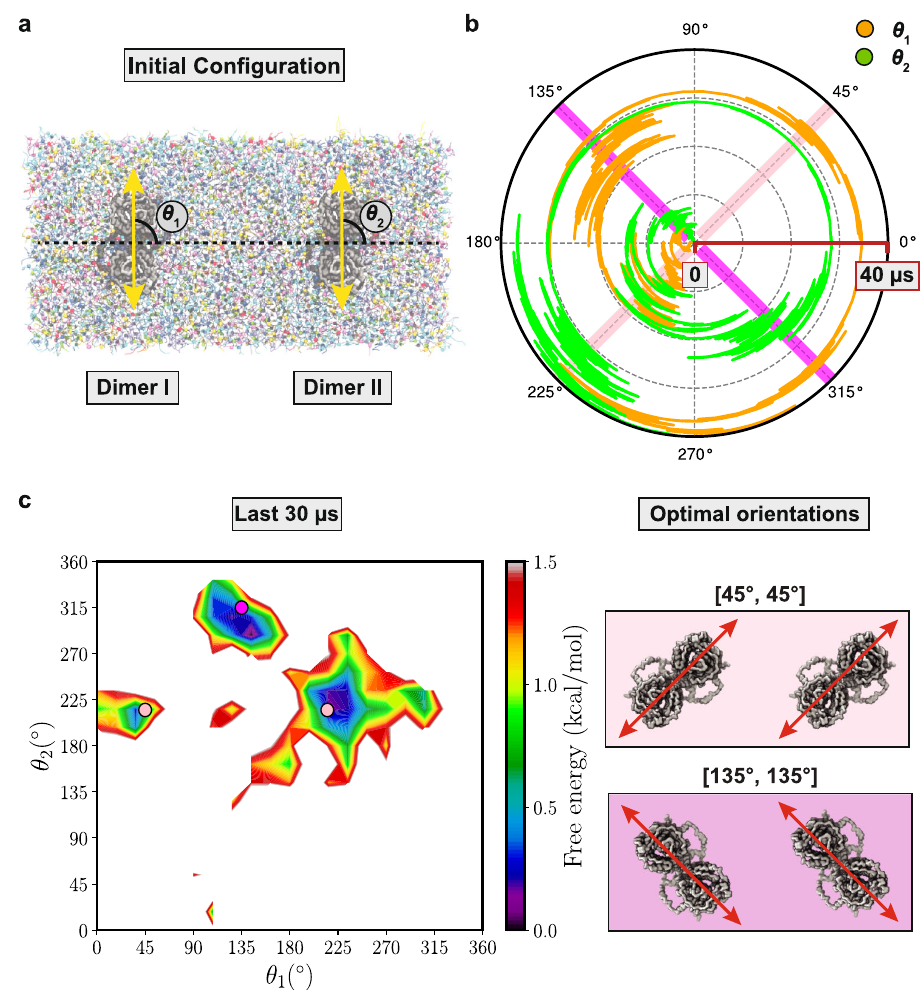
Fig.5|Prestin-prestincommunicationthroughlipids.a Initialsystemsetupwith twocontractedprestindimersat90°[90°,90°].Thecenterofmassofeachdimeris restrained, but they are allowed to rotate freely. Orientation of the two prestin dimers are denoted as θ 1 and θ 2 , respectively. b Time series of θ 1 (orange) and θ 2 (green) during the 40 μ s simulation. The radial direction in the polar plot